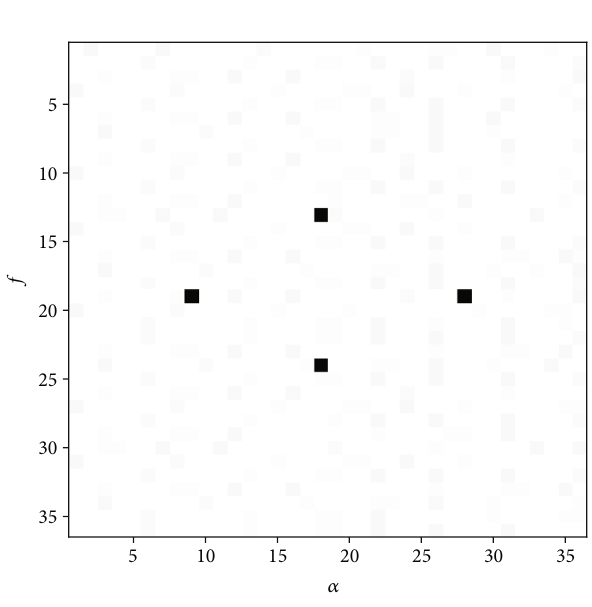
Figure 4: Gray scale image H